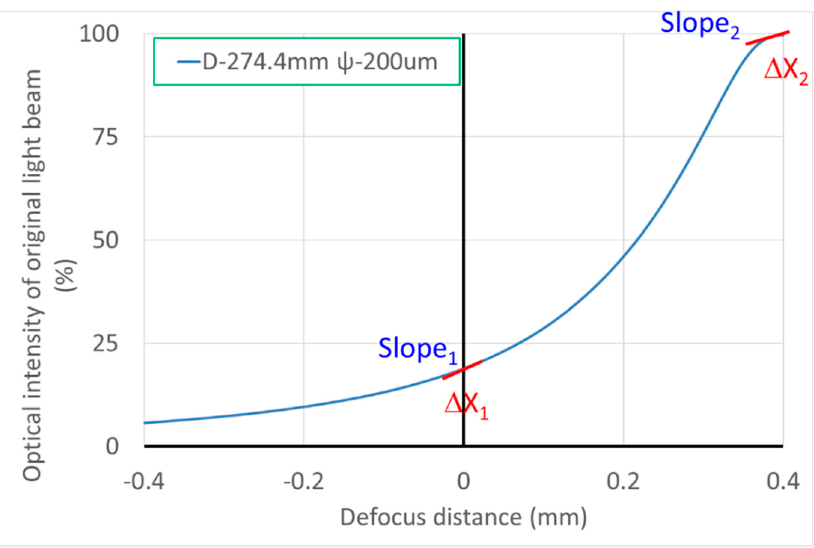
Figure 9. The key index of the characteristic curve in our focusing system.